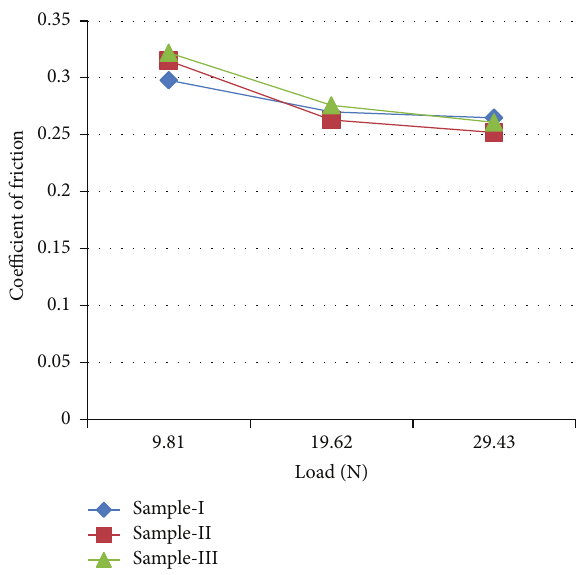
Figure 7: Variation of coefficient of friction with applied load.